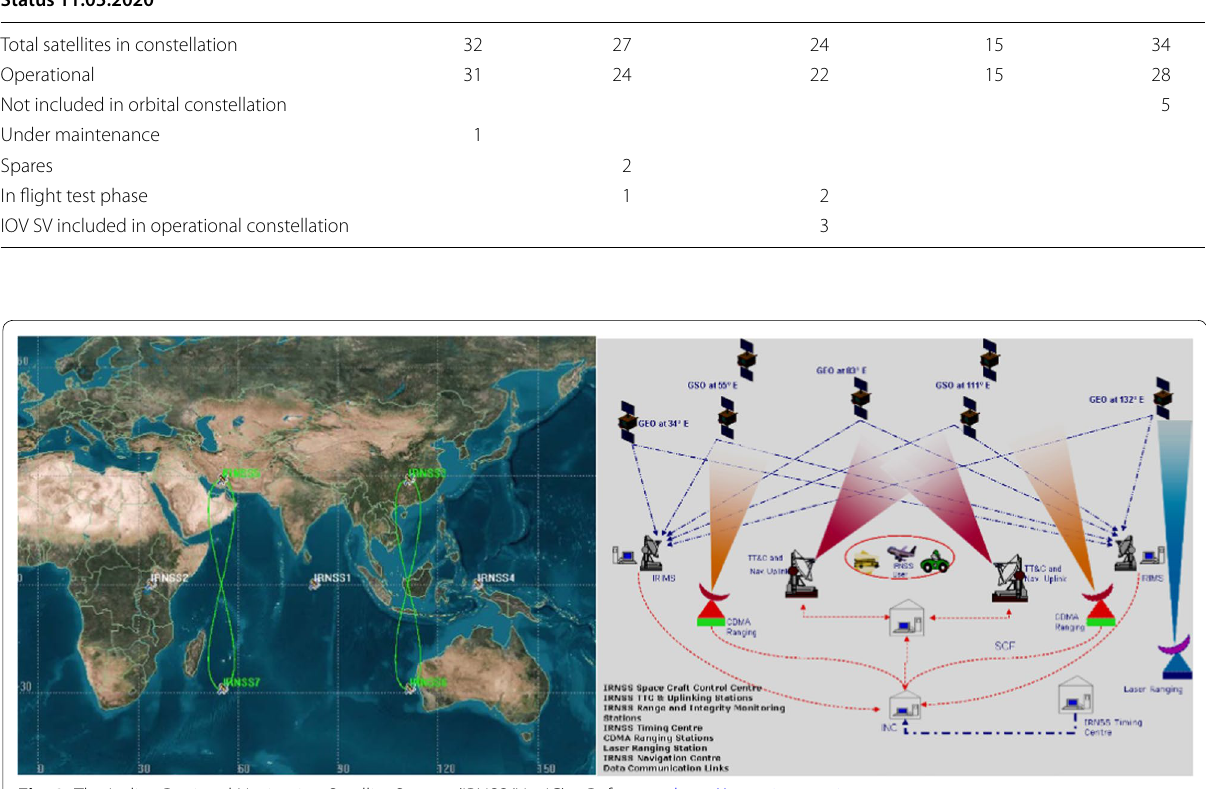
Fig. 3 The Indian Regional Navigation Satellite System (IRNSS/NavIC)—Reference: